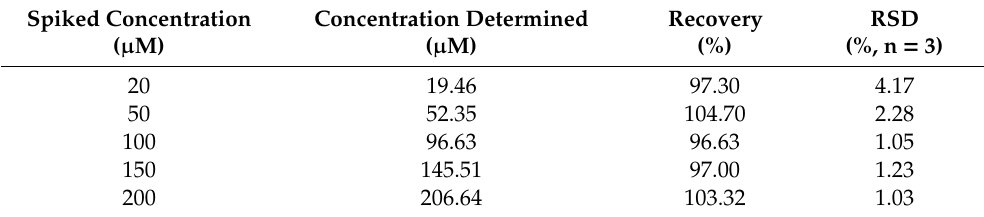
Table 2. Results for the determination of Cr(VI) in spiked tap water samples.